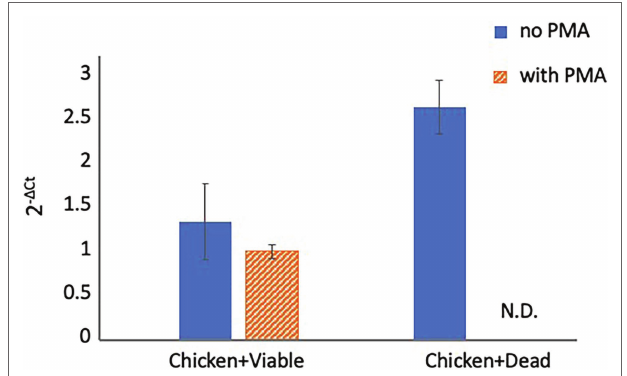
FIGURE 3 | Detection of Campylobacter spp. in spiked chicken juice. The chicken juice was spiked with 5 × 10 4 CFUs of viable cells and dead cells and treated with PMA before DNA extraction and qPCR. The columns display mean values from three independent experiments ± standard deviation. CFU, colony-forming unit; N.D., not detected; PMA, propidium monoazide; and qPCR, quantitative polymerase chain reaction.